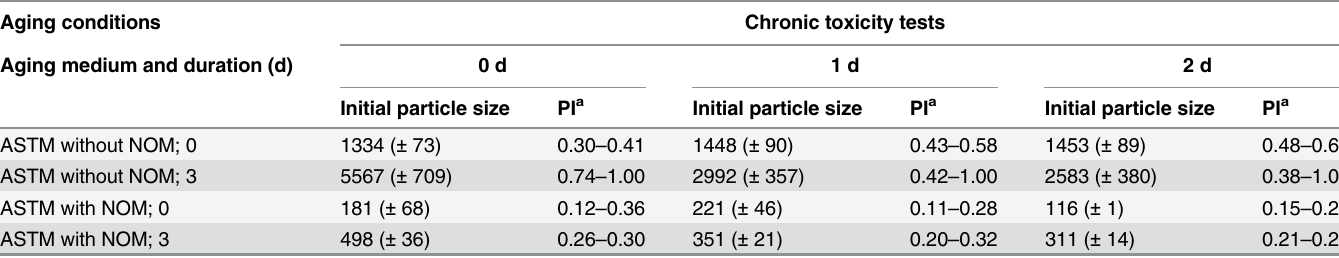
Table 2. Particle size during chronic toxicity